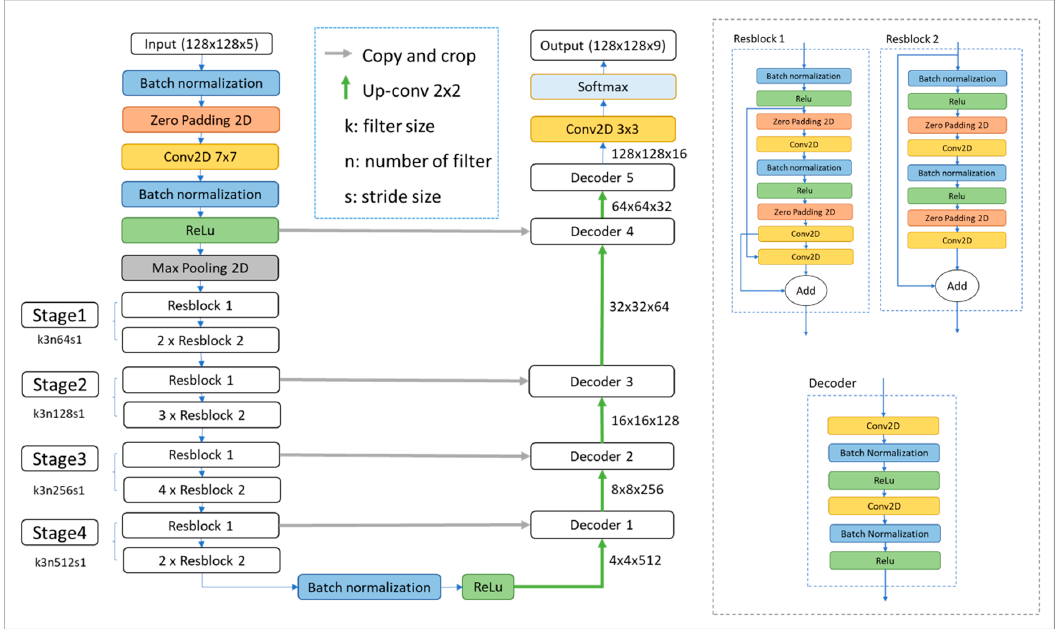
Figure 4. ResU-Net structure for training a model to classify coastal wetland ecosystem types.